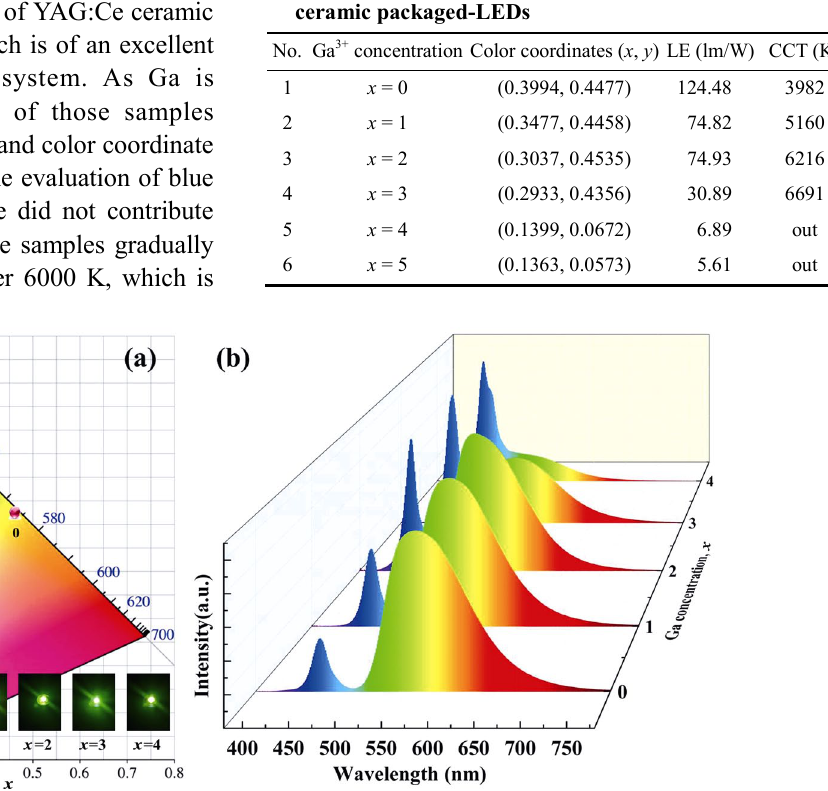
Fig. 9 (a) Chromaticity color coordinates of LEDs encapsulated with YAGG:Ce ceramics. Inset: pictures of the blue LED chip encapsulated with Y 3 Al 5– x Ga x O 12 :Ce ( x = 0–4) ceramics in operation (from left to right). (b) Spectra of LEDs encapsulated with YAGG:Ce